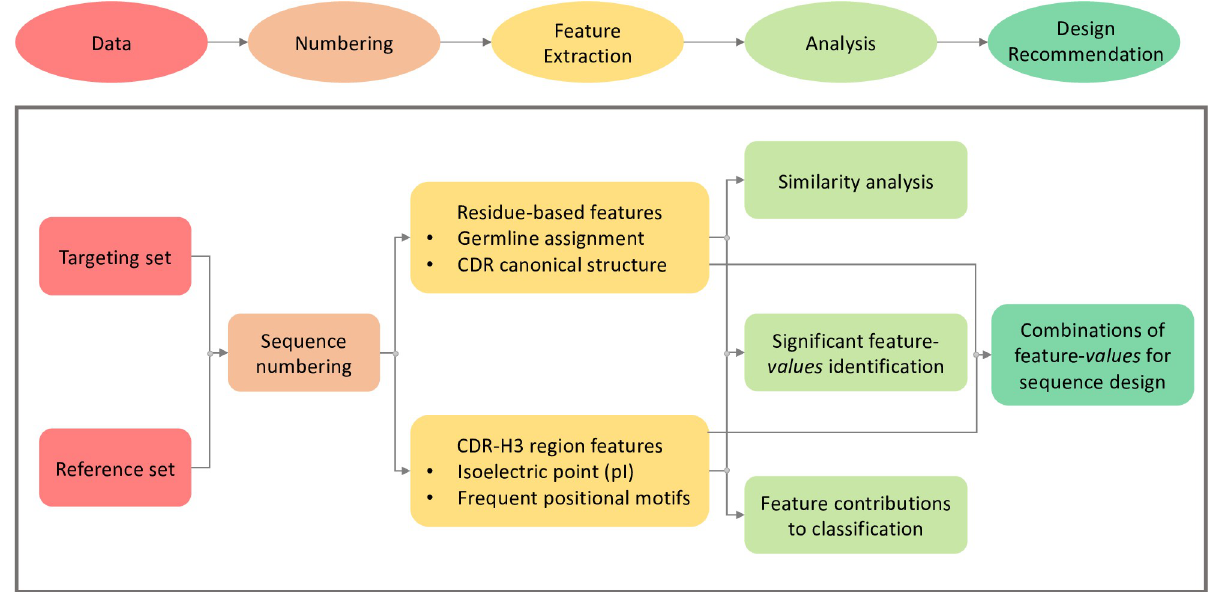
Fig 1. ASAP-SML pipeline overview. Antibody sequences in the targeting and reference sets are inputted into the pipeline to perform sequence numbering, feature extraction, sequence and feature analysis, and design recommendations.